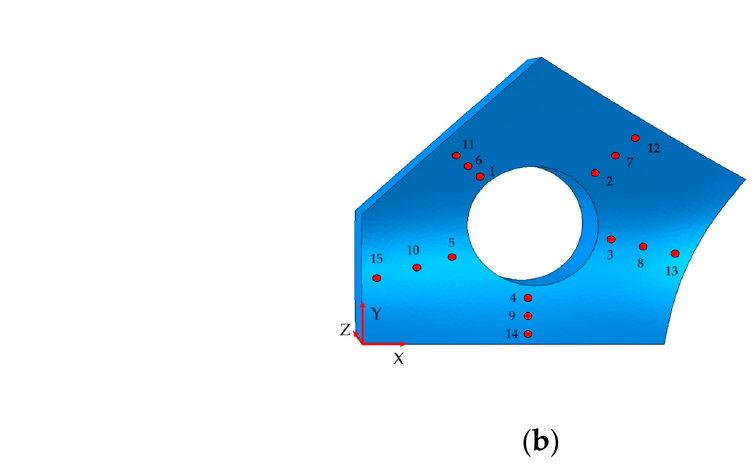
Figure 3. Residual stress test: ( a ) a projection of the forging in the XOY plane; ( b ) the position of the XRD measurement points in forging. Table 2. XRD measurement